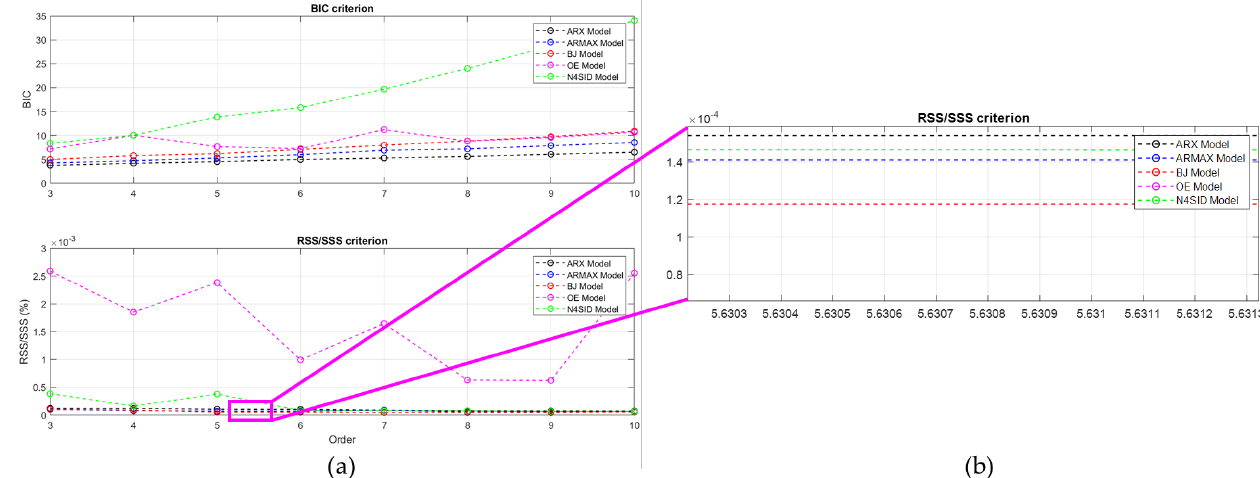
Figure 10. BIC and RSS/SSS criterion for determining the order ( a ), close-up of the RSS/SSS ( b ).